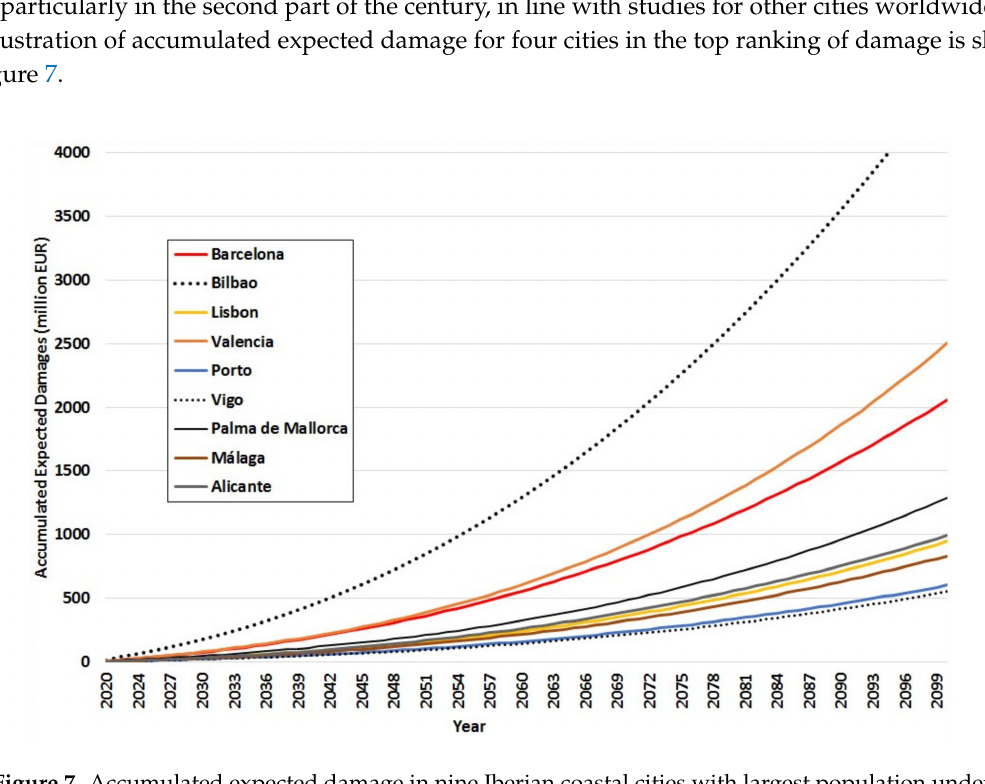
Figure 7. Accumulated expected damage in nine Iberian coastal cities with largest population under RCP